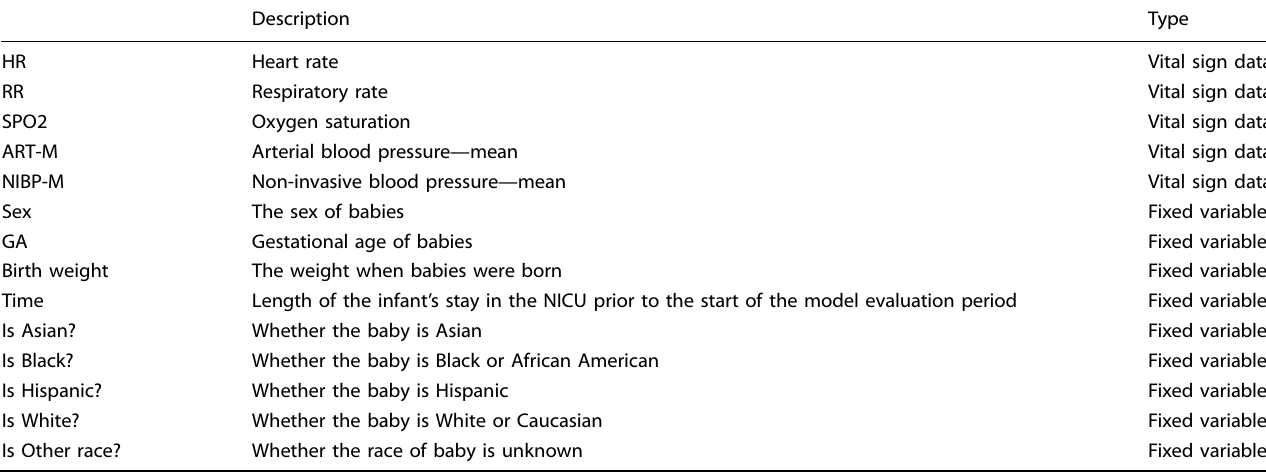
Table 12. Prediction